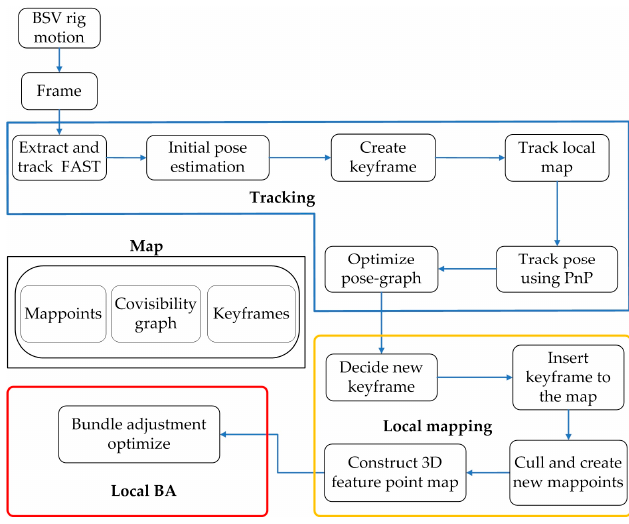
Figure 2. Lightweight monocular visual SLAM system.